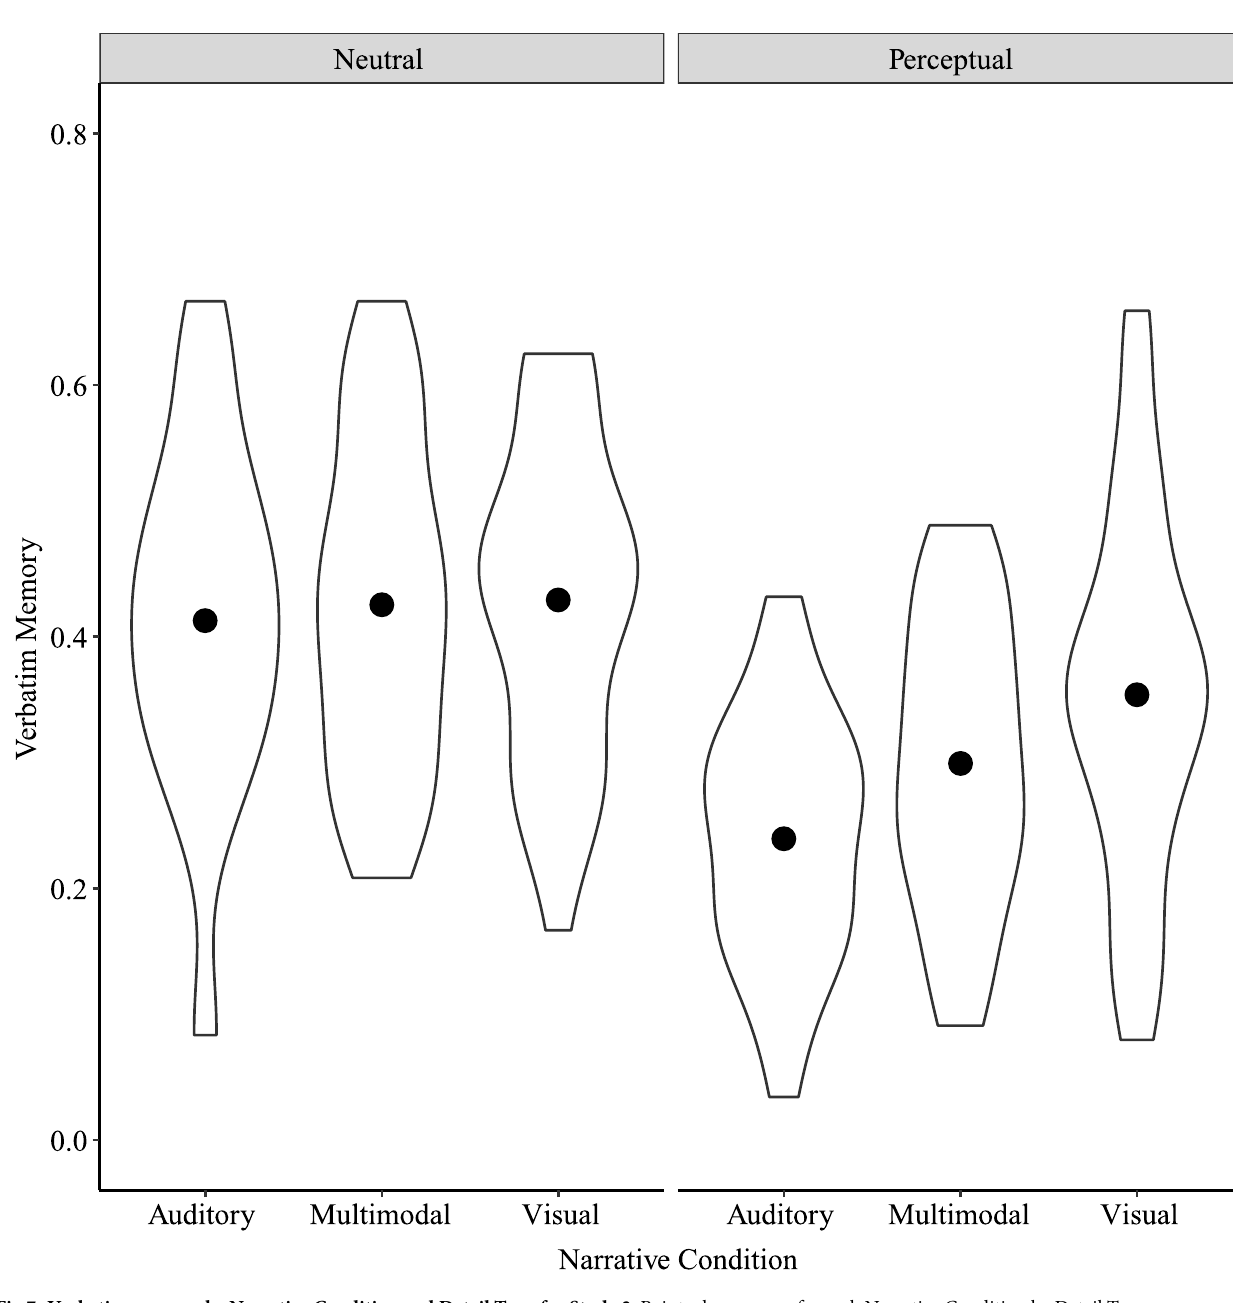
PLOS ONE | https://doi.org/10.1371/journal.pone.0249950 April 14,